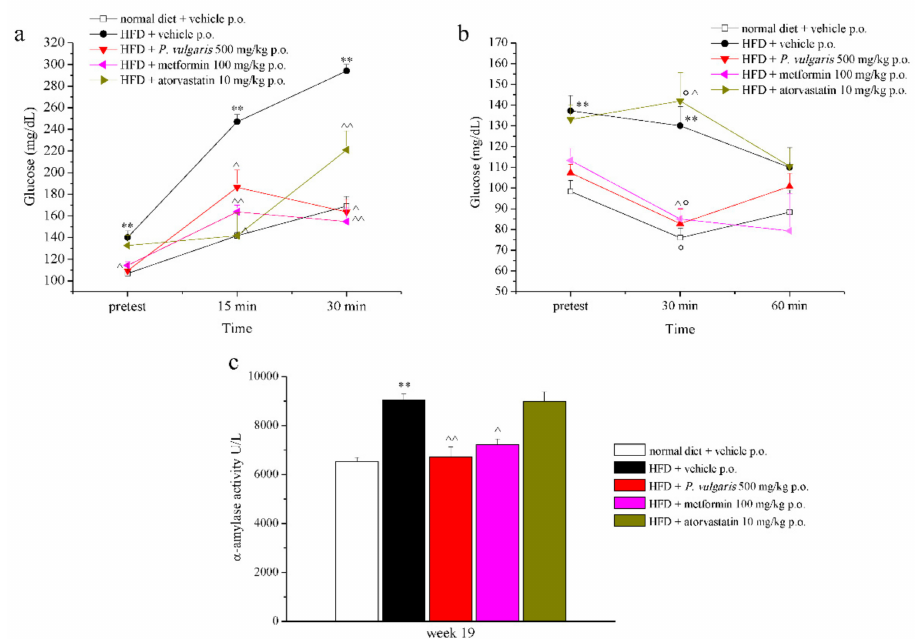
Figure 2. Glucose and insulin tolerance and α -amylase activity. ( a ) E ff ects of HFD and treatments on glucose tolerance test at week 19; blood glucose was measured before the test (pre-test), and 15 and 30 min after the test. ( b ) E ff ects of HFD and treatments on insulin tolerance test at week 19. Glucose blood dosages were performed before the test (pre-test), and 30 and 60 min after the test. ( c ) E ff ects of HFD and treatments on the activity of α -amylase (U / L) in plasmatic sample from animals at week 19. Each value represents the mean ± S.E.M. of 12 mice per group. ** p < 0.01 vs. group normal diet + vehicle;